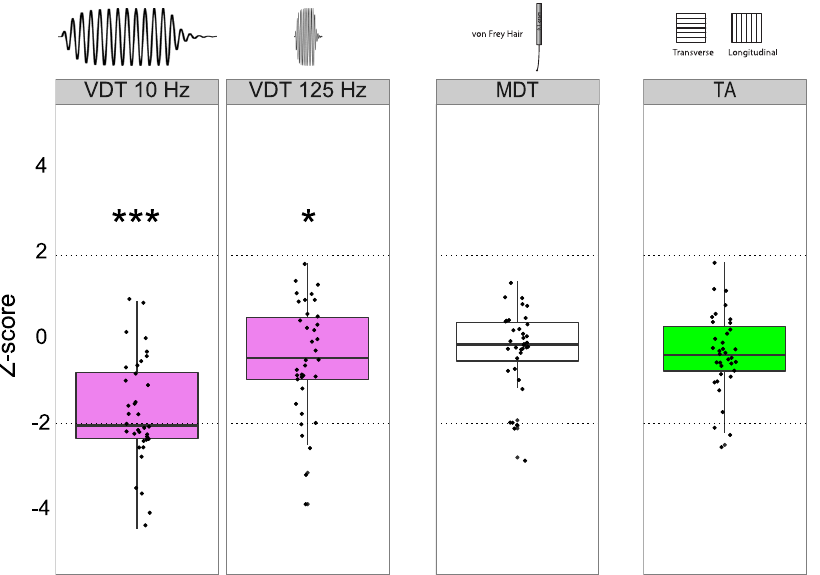
one-way ANOVA, F (1,109) = 16.2, P = 0.0001). Finally, warming detection thresholds were lower in control females (mean ± SD, Δ °C; females: 1.6 ± 0.4, males 1.8 ± 0.6; one-way ANOVA, F (1,109) = 4.7, P = 0.03). There were no significant differences in performance between the two sexes for any of the other test parameters (Table 1). Hearing impaired subjects showed a robust and highly significant impairment in vibration detection ability compared to the control cohort (Table 1, Fig. 2). Vibration detection thresholds were significantly elevated for both the 10 and 125 Hz tasks, but the difference between the cohorts was largest for the 10 Hz task. The mean amplitude detected by hearing impaired subjects was shifted almost 2 fold to 7.24 µ m compared to 3.66 µ m in healthy controls and this was highly statistically significant (two-way ANOVA F (1,143) = 68, P < 0.0001) (Fig. 2, and Table 1). Post-hoc tests revealed that both deaf males and females had higher vibration detection threshold than healthy males and females respectively (Post hoc Tukey test; P < 0.05). Since the performance of males and female